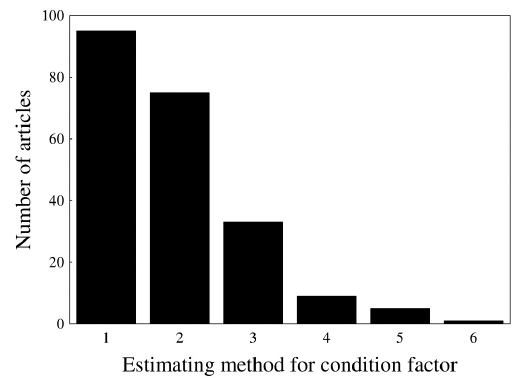
Figure 6. Methods used to estimate the body condition factor identified in the papers that cited ‘Le Cren, 1951’ based on a search from 1951 to December 2015. 1: Le Cren’s condition factor; 2: Fulton’s condition factor; 3: relative weight; 4: Quételet’s index or body mass index; 5: residual index; and 6: scaled mass index (for more details, see Table